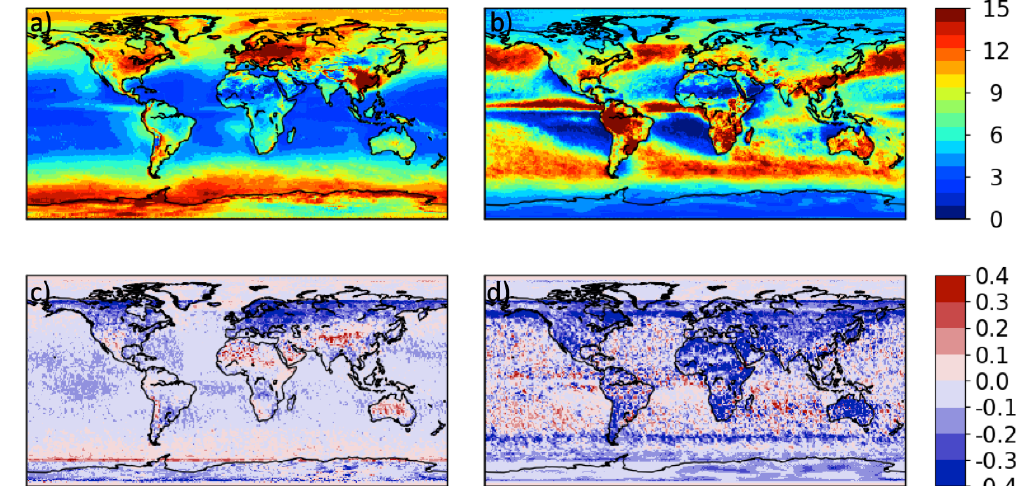
Figure 6. Multi-year (2014–2018) mean daytime liquid cloud optical depth ( a ) and ice cloud optical depth ( b ) from S-NPP VIIRS retrieval, and the cloud optical depth difference between retrievals using all footprints and only using footprints with VZA < 66 ◦ for liquid cloud ( c ) and ice cloud ( d ).